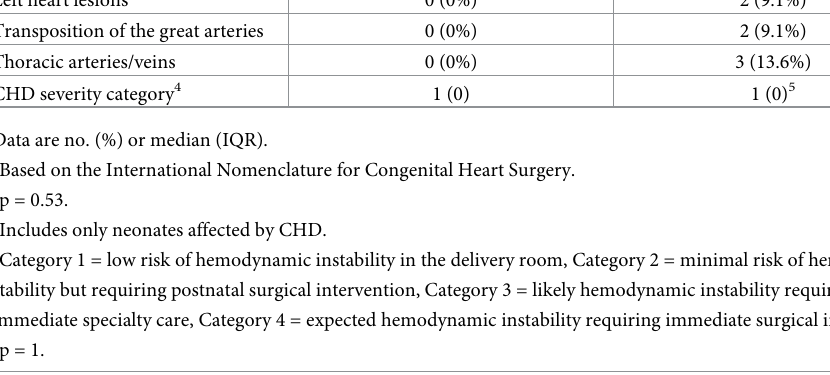
Table 1. Spectrum of CHD in concordant and discordant MC twins, as diagnosed by prenatal echocardiography. Diagnosis 1,2 Concordant CHD Cohort (n = 10) 3 Septal defects 10 (45.5%) Systemic venous anomalies 0 (0%) 1 (4.5%) Right heart lesions 4 (40%) 4 (18.2%) Left heart lesions 0 (0%) 2 (9.1%) Transposition of the great arteries 0 (0%) 2 (9.1%) Thoracic arteries/veins 0 (0%) 3 (13.6%) CHD severity category 4 1 (0) 1 (0) 5 Data are no. (%) or median (IQR).